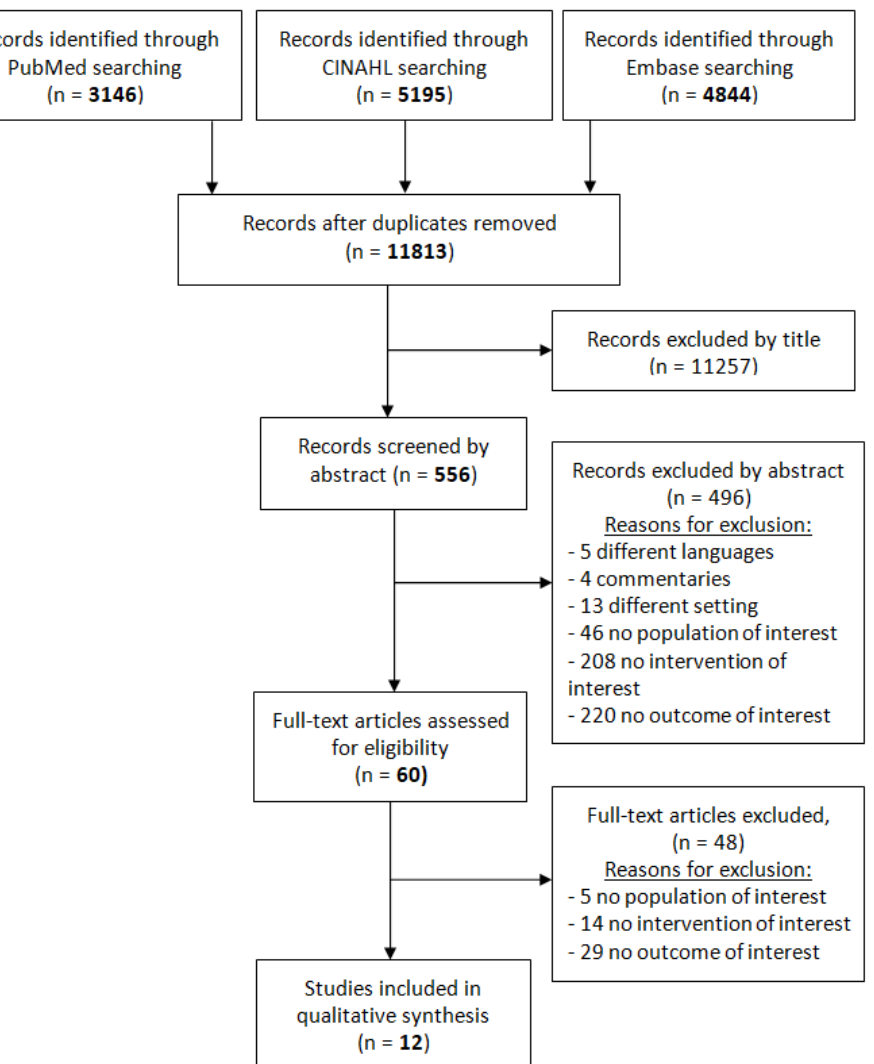
Figure 1. PRISMA Flowchart of articles selection.